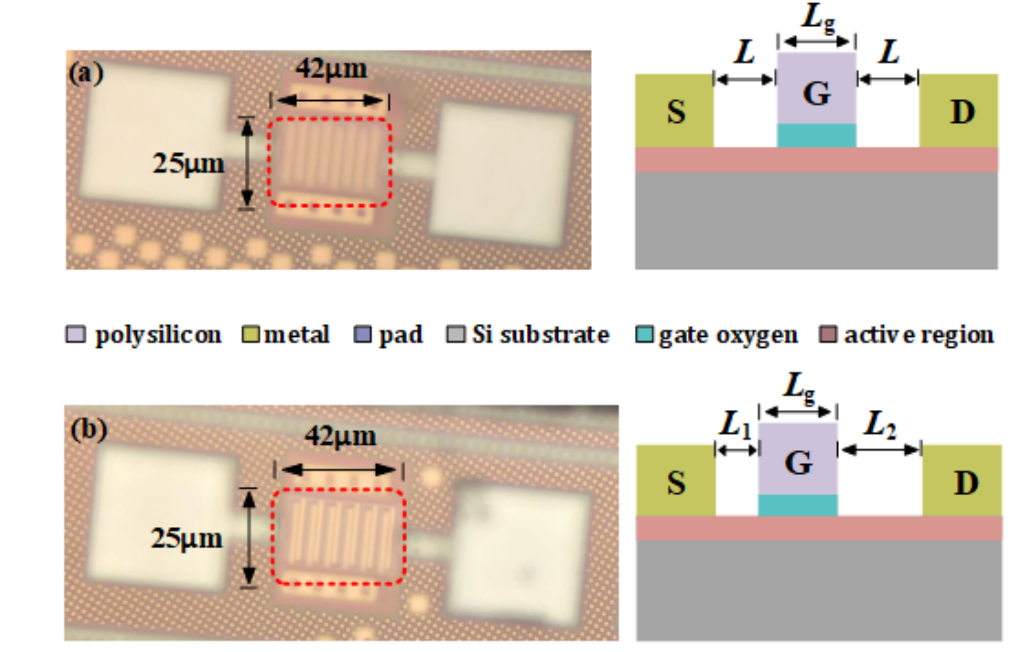
Figure 3. ( a ) Die micrograph and cross-section of the symmetrical detector; ( b ) die micrograph and cross-section of the asymmetrical detector.